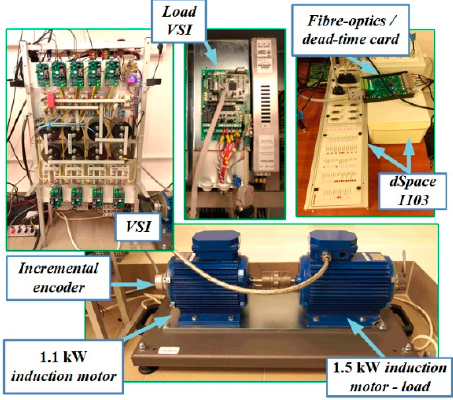
Figure 4. Photograph of the experimental set-up.